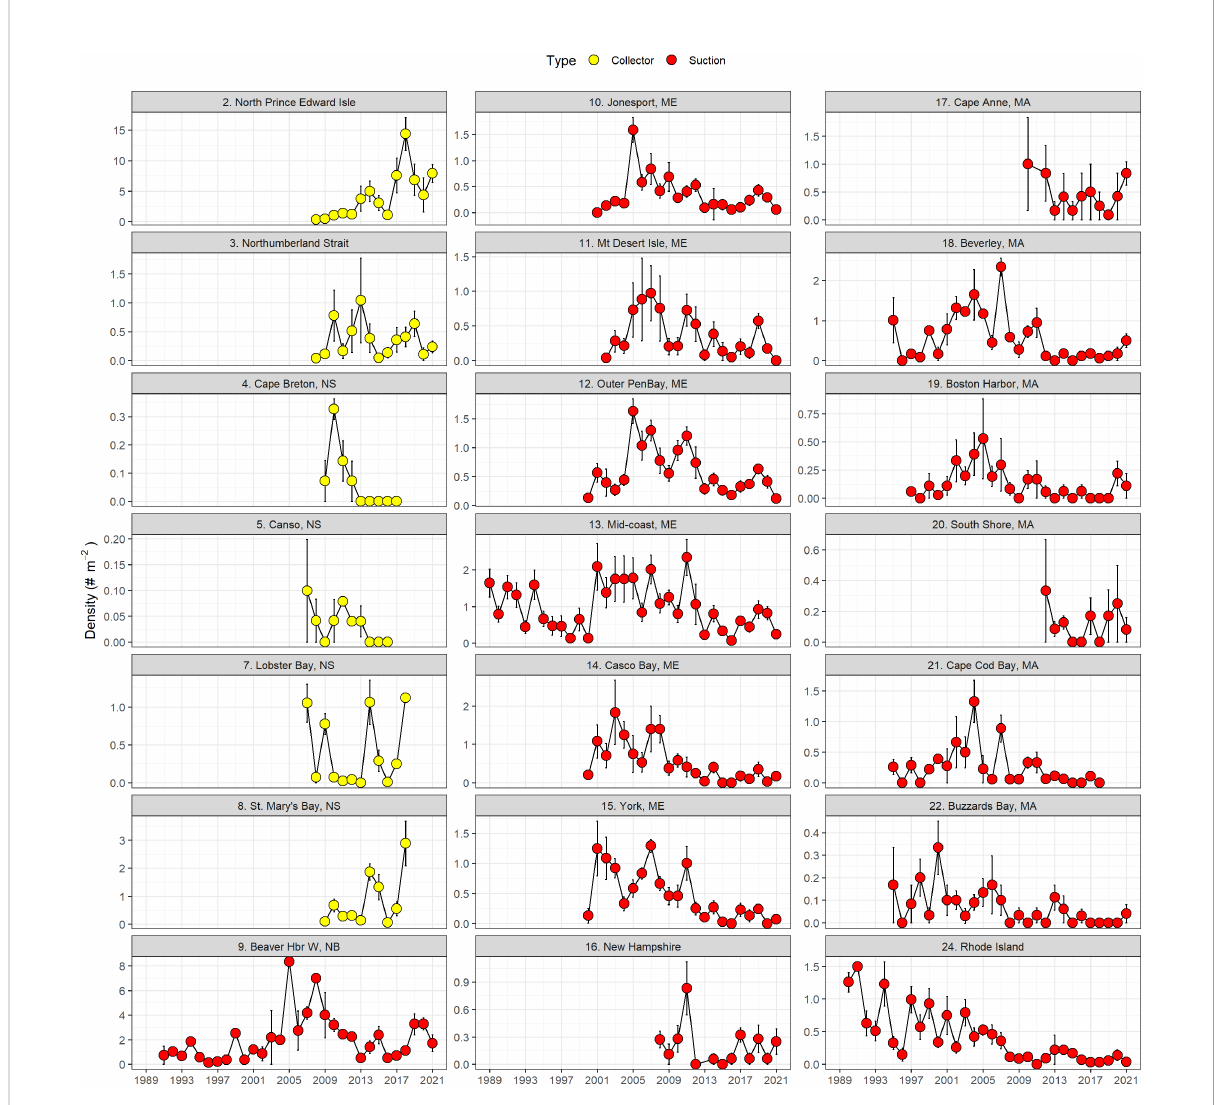
FIGURE 2 Mean (± 1 SE) annual indices for young-of-year (settler) American lobster (# m -2 ) for select study areas enumerated in Figure 1, each consisting of 4-10 sampling sites. Indices are colored by collection method: suction sampling (red), passive collectors (yellow). For regions using both methods simultaneously, the prevailing method used to derive indices is